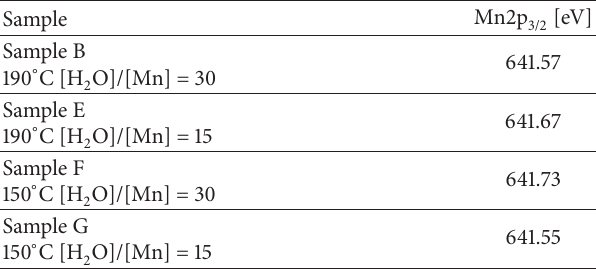
Table 4: Binding energy of Mn2p various parameters.